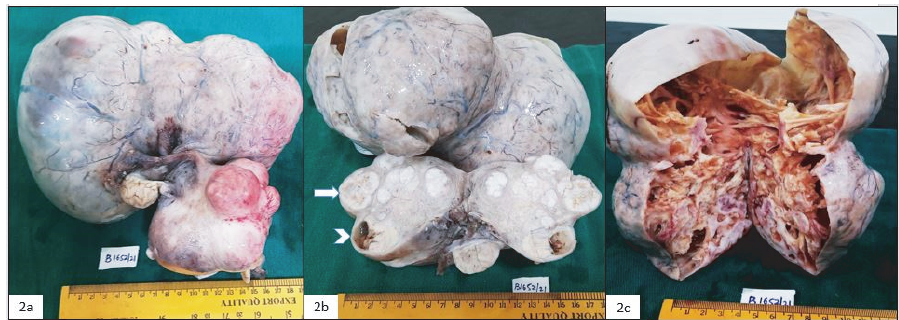
Figure 2 : (a) Uterus with adnexa and leiomyoma showing bosselated surface. (b) Cut section showing multiple intramural fibroids with cystic cavitation (arrow head) and calcifications (arrow). (c) Cut section of giant degenerated fibroid measuring 25x20x13 cm with solid and cystic areas.